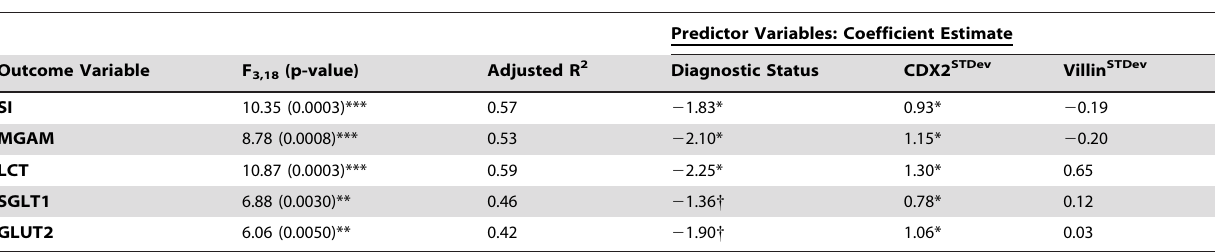
Table 3. Multiple linear regression analysis examining CDX2 and villin as predictors of disaccharidase and transporter mRNA expression among AUT-GI and Control-GI